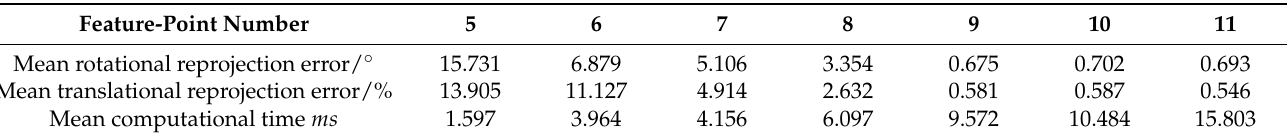
Table 5. The influence on pose estimation accuracy and computation time when feature-point number